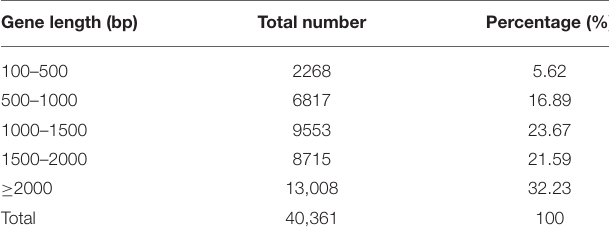
FIGURE 3 | Change in gene expression profiles among different N forms. S1, NH + 4 treatment; S2, NH 4 NO 3 ; S3, NO − 3 . The number of up-regulated and down-regulated genes between S1 and S2, and between S2 and S3 are summarized. Between the S1 and S2 libraries, there are 33 up-regulated genes and 79 down-regulated genes, while 76 up-regulated genes and 95 down-regulated genes between the S3 and S2 libraries, and 130 up-regulated genes and 189 down-regulated genes between the S1 and S3